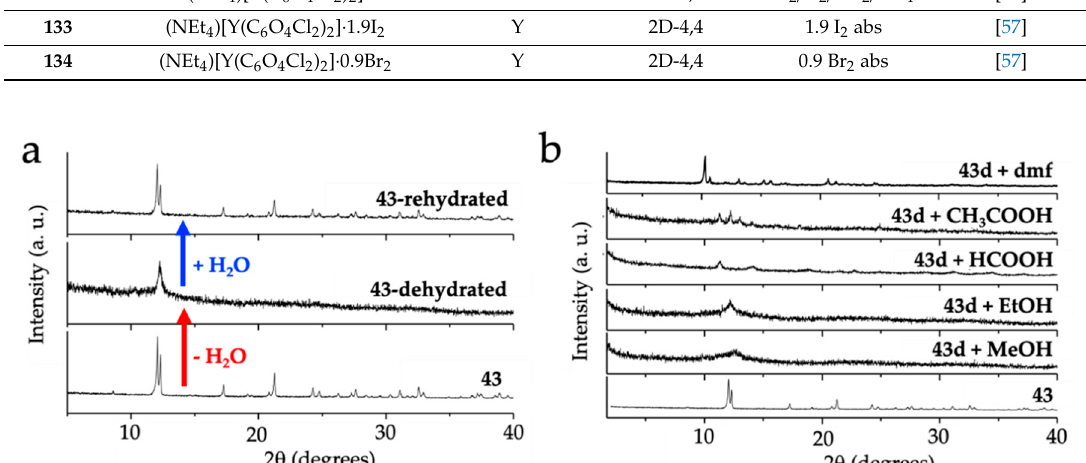
Figure 24. ( a ) X-ray powder di ff ractogram of compound (Pr 2 (dhbq) 3 (H 2 O) 6 ) · 18H 2 O ( 43 ), its dehydrated form and the rehydrated one, showing the collapse of the structure upon dehydration and the reversibility of the process. ( b ) X-ray powder di ff ractogram of compound 43 and the solvated compounds obtained from the dehydrated compound ( 43d ) by immersion in di ff erent solvents.